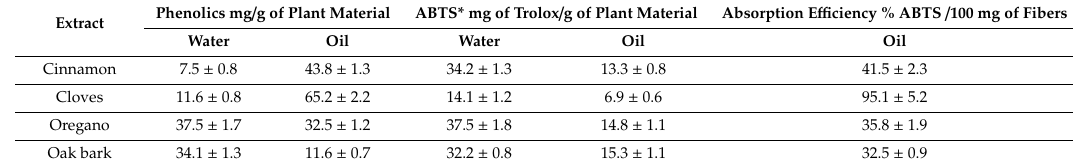
Table 4. Characteristics of extracts and adsorption capacity to PHB (polyhydroxybutyrate) fibers. Extract